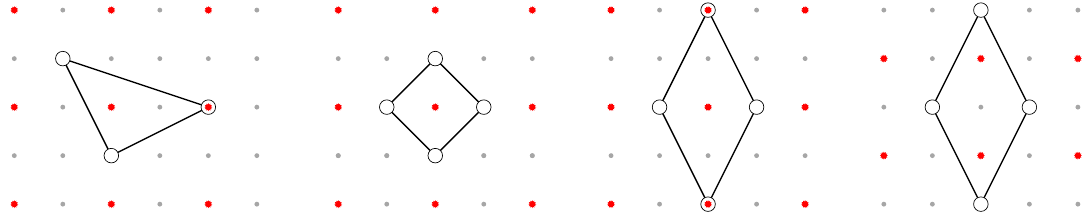
Figure 1. Examples of toric diagrams with choice of even sublattice. The first and third graphs describe cases where some vertices of the toric diagam lie within the chosen even sublattice. Such examples will not be considered in the present work.